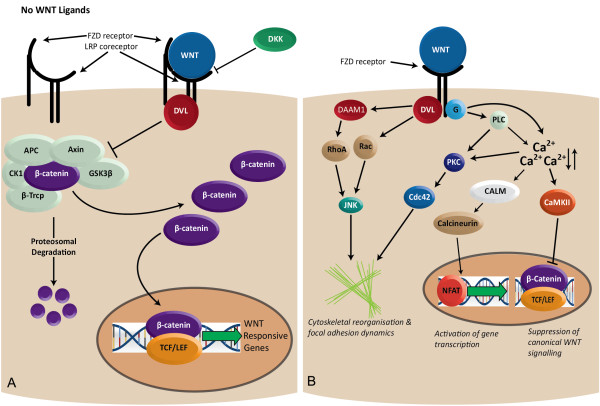
Wnt signalling pathways implicated in diabetic nephropathy. Eleven genes encoding members of the Wnt signalling pathway were prioritized for assessment of association with diabetic nephropathy (AXIN1, CALM3, CTNNB1, DAAM1, DKK2, GSK3B, NFAT5, WNT3, WNT5A, WNT6 and WNT16). (A) Canonical WNT signalling: Some WNT ligands bind to FZD and LRP receptors. DKK internalises the LRP receptors blocking canonical WNT signalling. DVL recruits the AXIN GSK3B destruction complex that is responsible for marking B-catenin for proteosomal degradation. (B) Non-canonical WNT signalling: Certain WNT ligands bind to FZD receptors and elicit the activation of DVL and heterotrimeric G-proteins which in turn can activate DAAM which regulates cytoskeletal organization and focal adhesion dynamics. In addition, activation of CALM regulates the transcription factor NFAT and modulates gene expression.